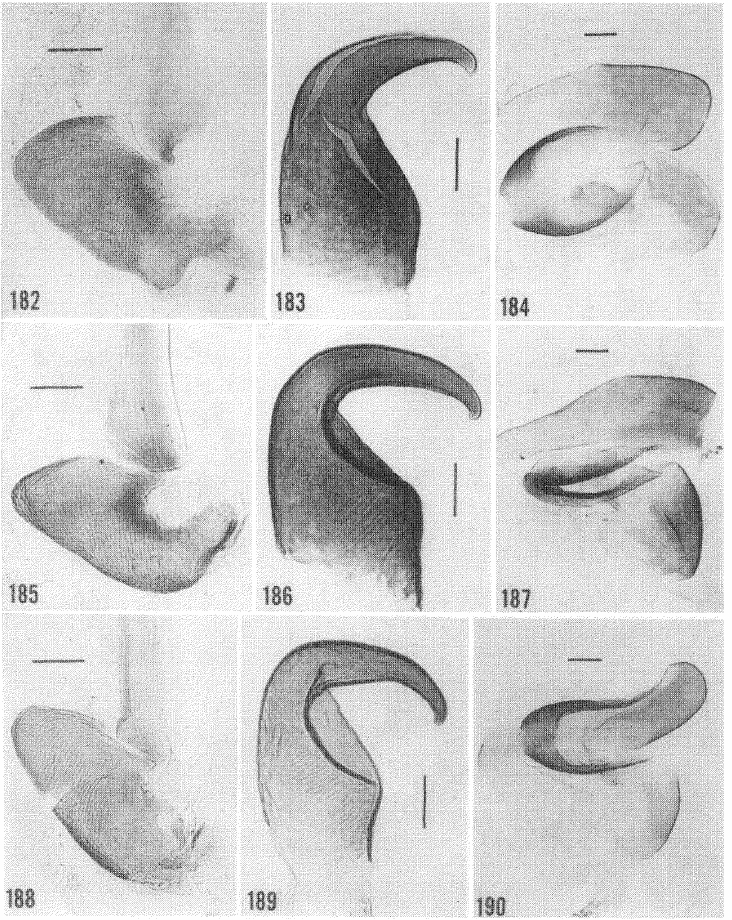
Figures 182-190. Male genital phallomeres of Derocalymma spp. 182-184. (1414 L). D. kalahari. (from sh,own in Fig. 163). 185-190. D. tTranulata. 185-187. (1413 L). (from shown in Fig. 164). 188-190, (143 ANSP). Damara (det. Rehn). (scale 0.1